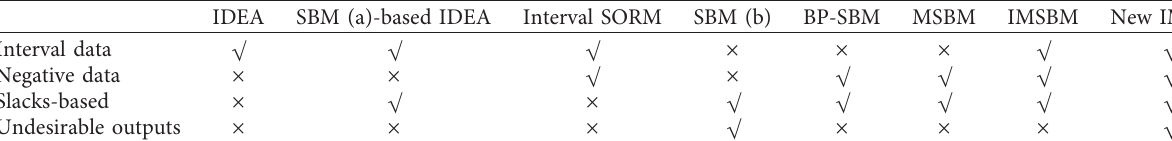
Table 1: Comparison of the new IMSBM model with other DEA